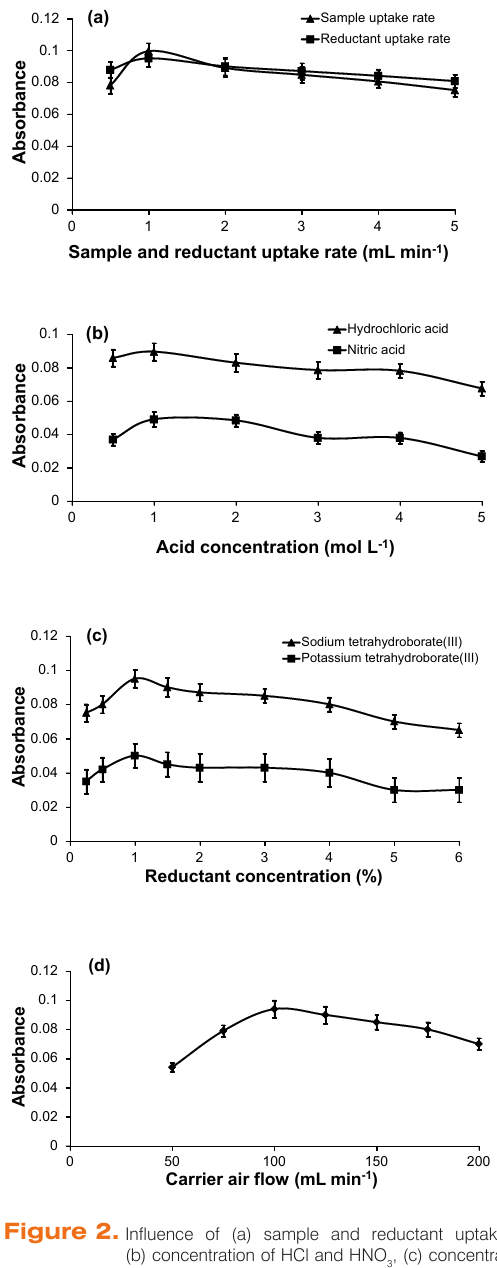
Figure 2. Influence of (a) sample and reductant uptake rate, (b) concentration of HCl and HNO , (c) concentration of 3 reductant, and(d) carrier gas flow rate on the peak area signals of Ni (20 ng mL -1 ) in continuous-flow system. The experimental conditions employed are detailed in the Experimental